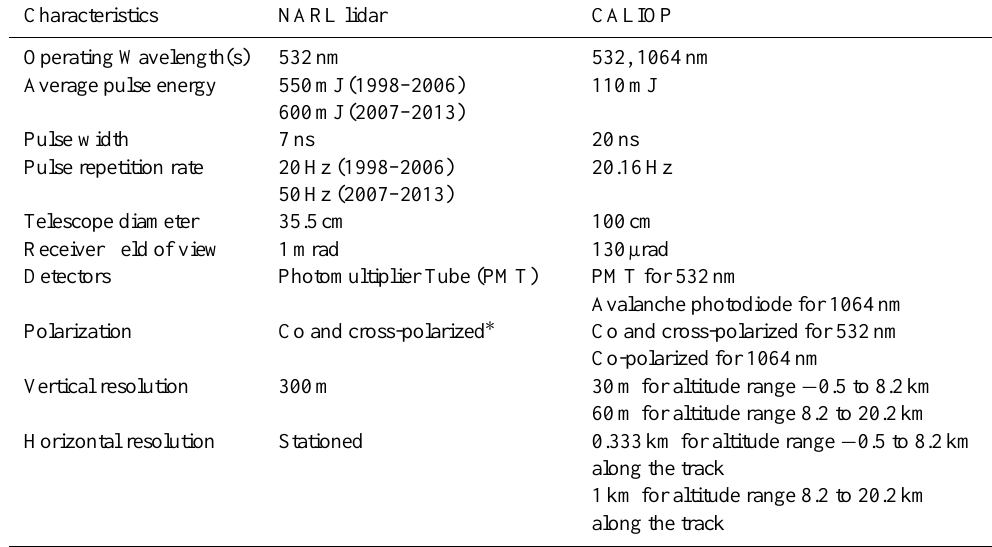
Table 1. Specifications of NARL-lidar and